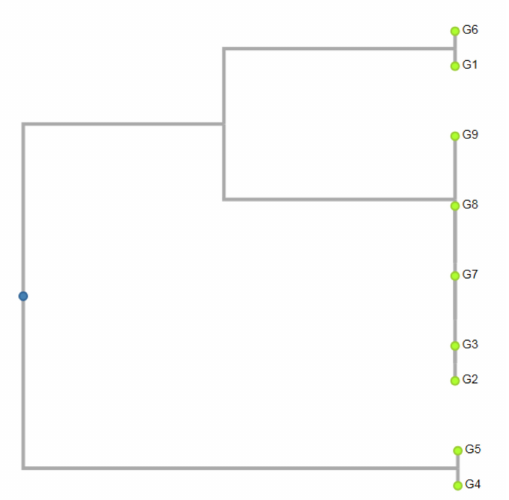
Figure 5. Dendrogram constructed by using unweighted pair group method using arithmetic averages (UPGMA) cluster analysis of 9 genotypes of Ginkgo biloba on miRNA markers gb-miR5261_F & gb-miR5261_R. G1—Nov á Ves nad Žitavou, G2—Topol’ˇcianky, G3—Luˇcenec, G4—Vel’k ý Blh, G5—Rimavsk á Sobota, G6—Pal á rikovo, G7—Šurianky, G8—Košice, G9—Budim í